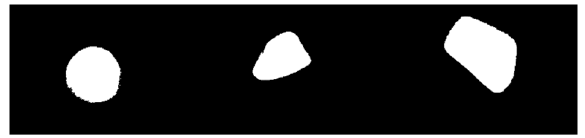
Figure 4. Images of amber gemstones after shadow removal.